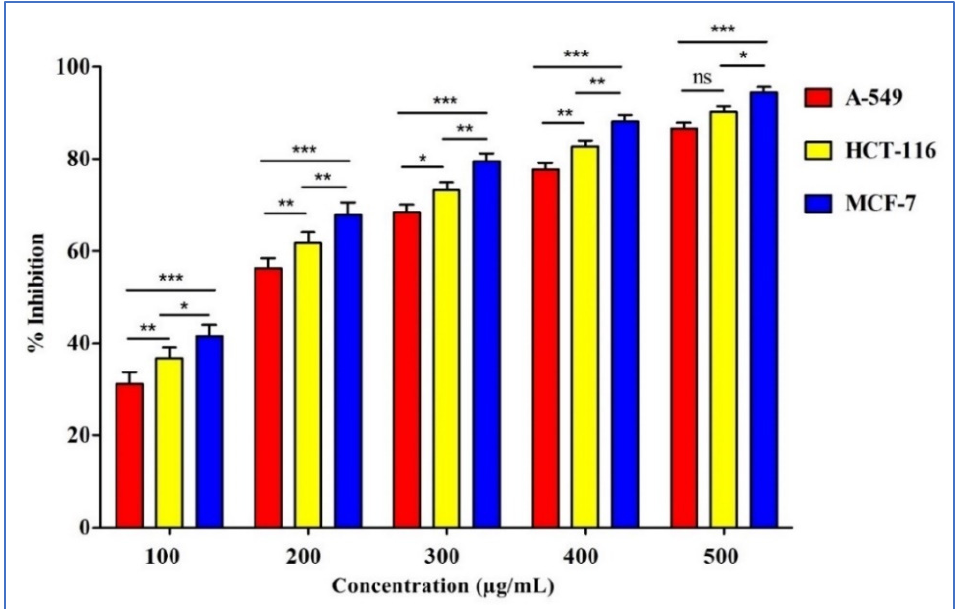
Figure 1. Effect of different concentrations from D. flabellifolia methanolic extract on breast (MCF-7), lung (A549), and colon (HCT-116) cancer cell lines. Error bars indicate SDs (± standard deviation) of three independent experiments. Significance; ns > 0.01, * p < 0.01, ** p < 0.001, *** p < 0.0001.